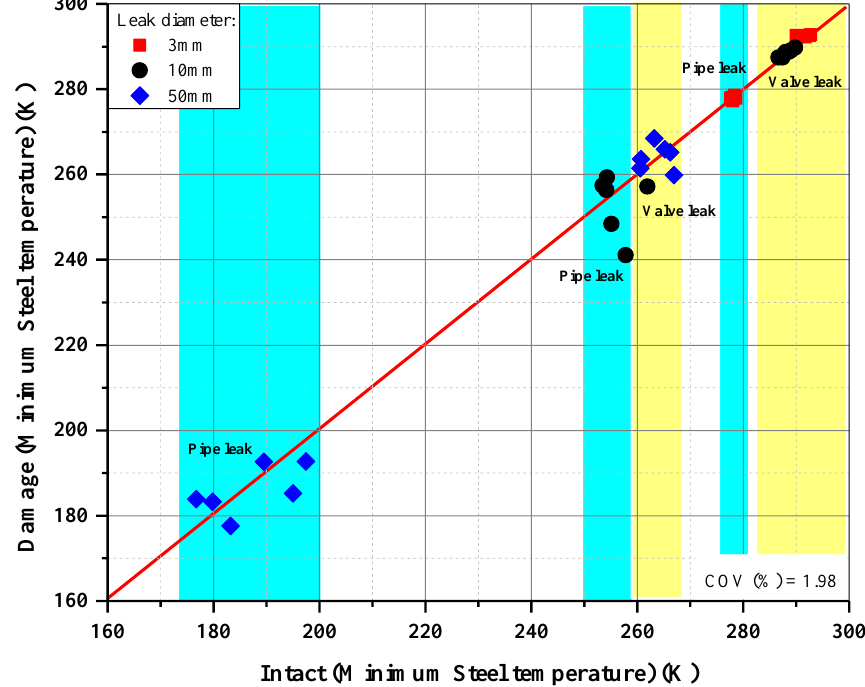
Figure 23. Plot of steel temperature between intact and damaged ships.